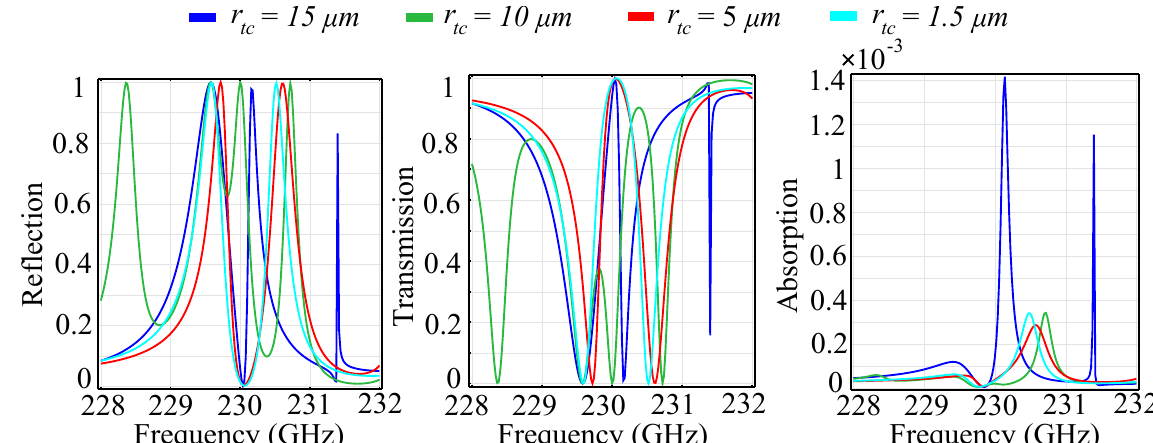
Figure 2. Simulated reflection, transmission, and absorption spectra for the silica glass reference cell in which the top radius of the inner-ring cylinder r tc is varied between fixed values, in a transition from a cylinder to a cone structure.